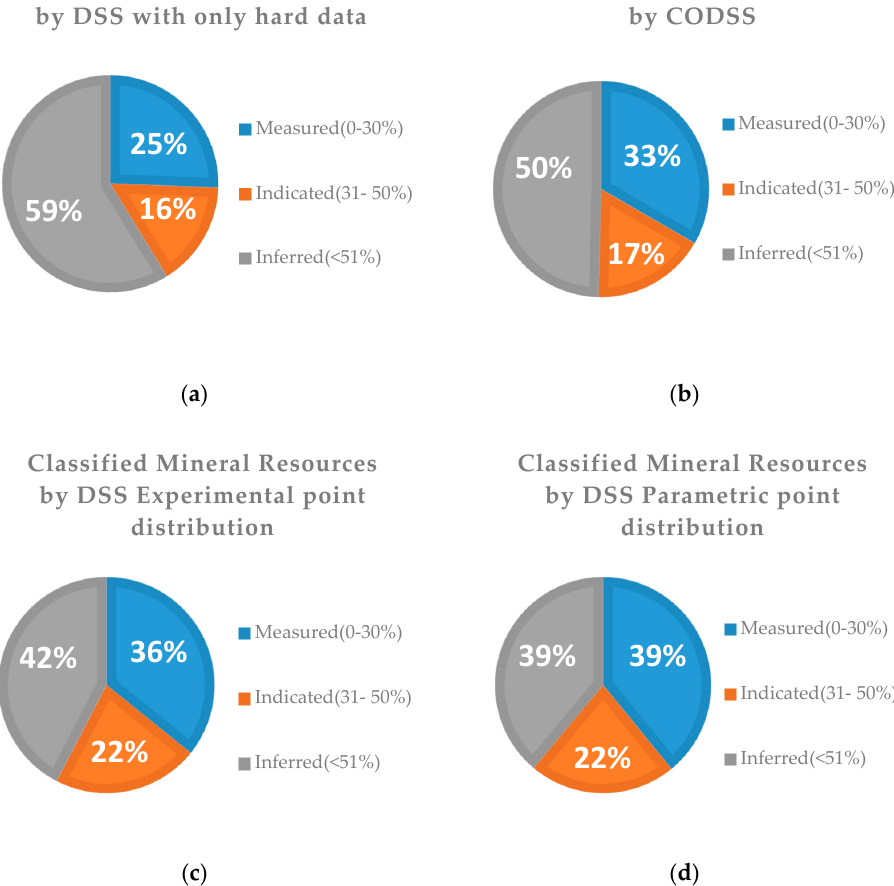
Figure 8. Proportions of the classified mineral resources as a function of the calculated error by using different strategies: ( a ) direct sequential simulation with only hard data, ( b ) direct sequential collocated co-simulation, ( c ) direct sequential simulation with experimental point distributions, and ( d ) direct sequential simulation with parameterized point distributions.